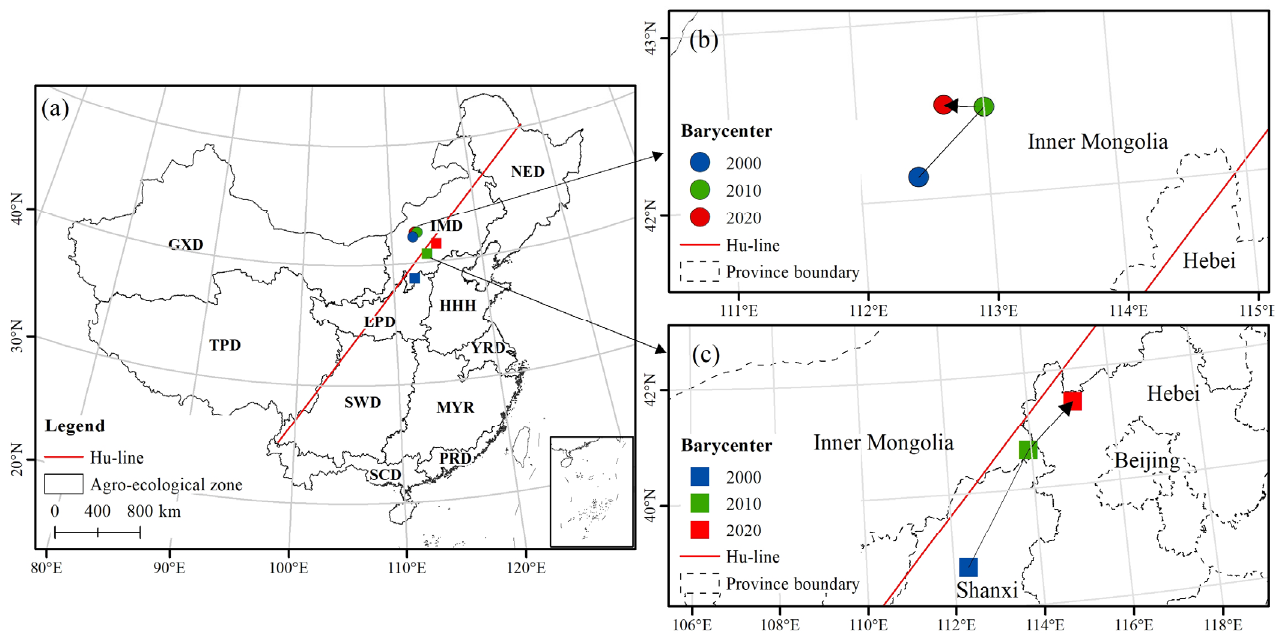
Figure A2. ( a ) The moving trajectory of the barycenter of China’s per capita cropland and per capita grain possession. ( b , c ) represent per capita cropland and per capita grain possession, respectively.